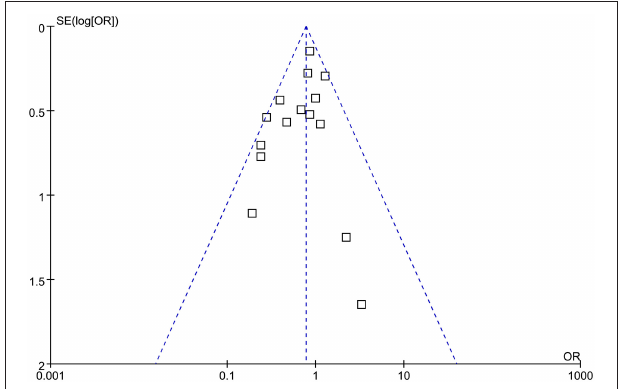
FIGURE 3 | Funnel plots for the meta-analysis comparing the influences of dexmedetomidine and controls on the incidence of POAF after cardiac surgery.